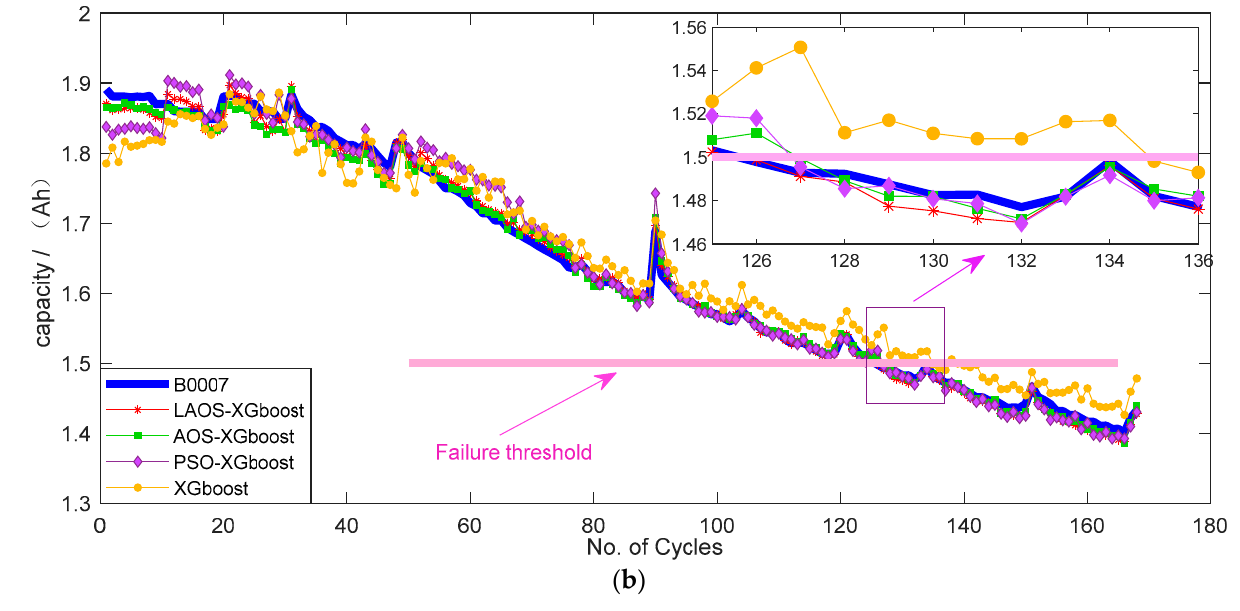
Figure 9. Prediction results of XGboost and its optimization model. ( a ) SOH prediction results of B0006 battery. ( b ) SOH prediction results of B0007 battery.